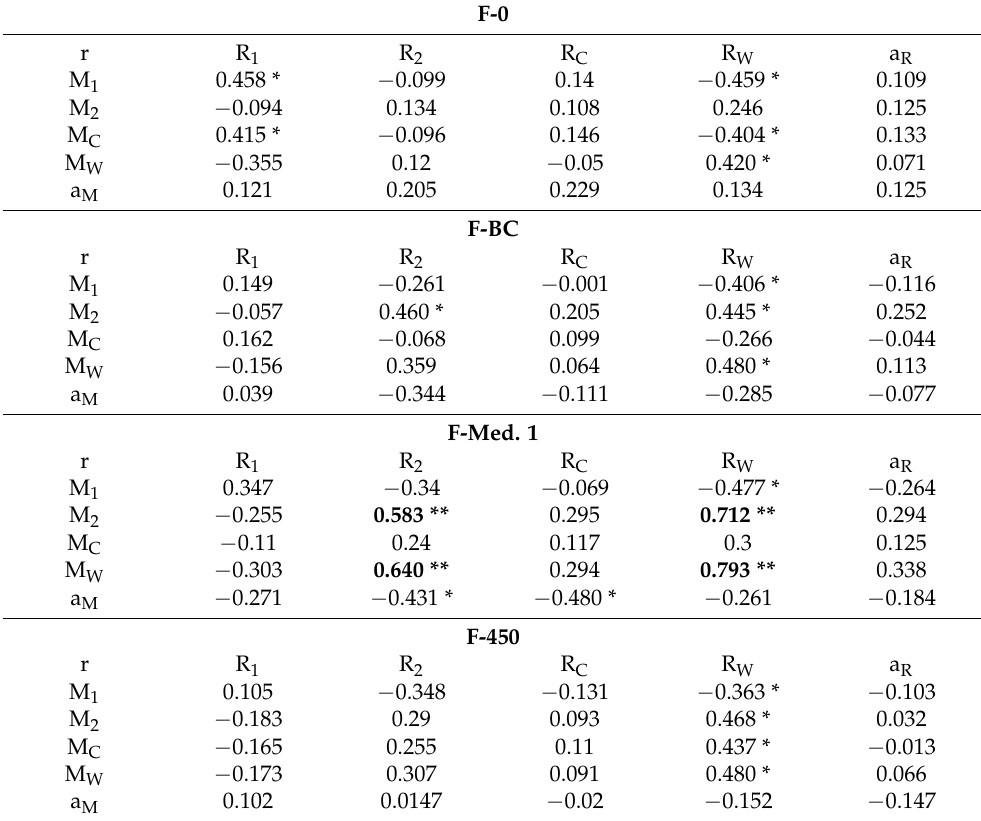
Table 5. Spearman’s rank correlations between the parameters of the Rayleigh and Moreland tests. It should particularly be noted that there is a strong correlation between R W and most of the Moreland test parameters for each of the filter types. A narrow matching range (R W ), i.e., good perception of shades in the lemon–orange range, was correlated to high M 1 , low M 2 and low M W , which means that efficient perception of color shades in both tests was correlated. The strongest correlations (|r| > 0.5) were observed in case of the F-Med1 filter and were presented in detail in Figure 5. *— p < 0.05, **— p < 0.01 (marked with bold).